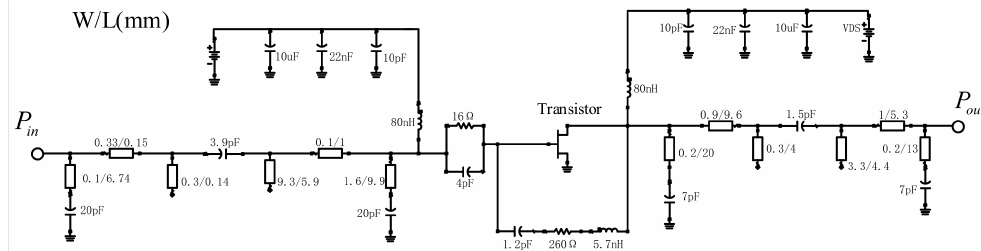
Figure 11. The proposed PA